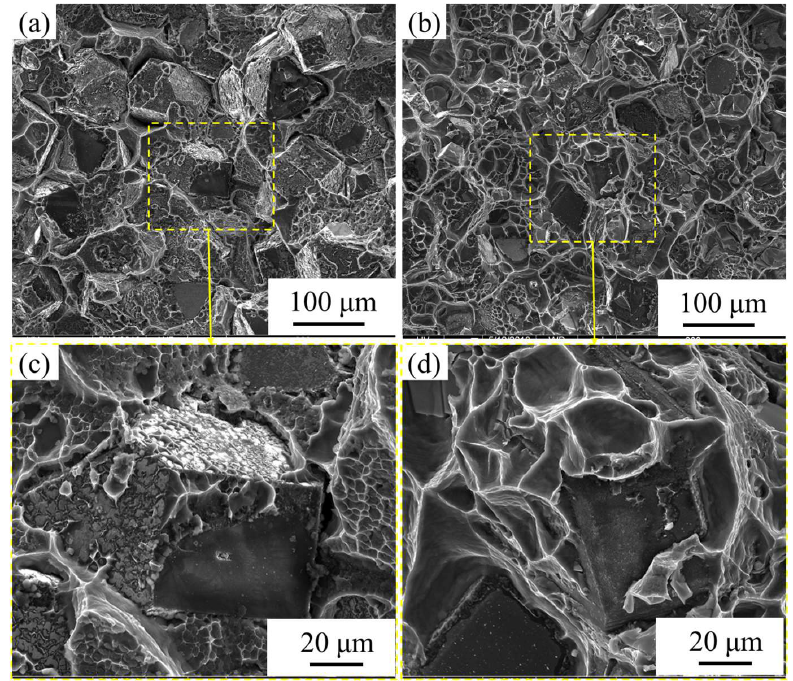
Figure 10. Fracture morphology of diamond/aluminum composite after corrosion: ( a , c ) uncoated; ( b , d ) nanoscale W-coated.